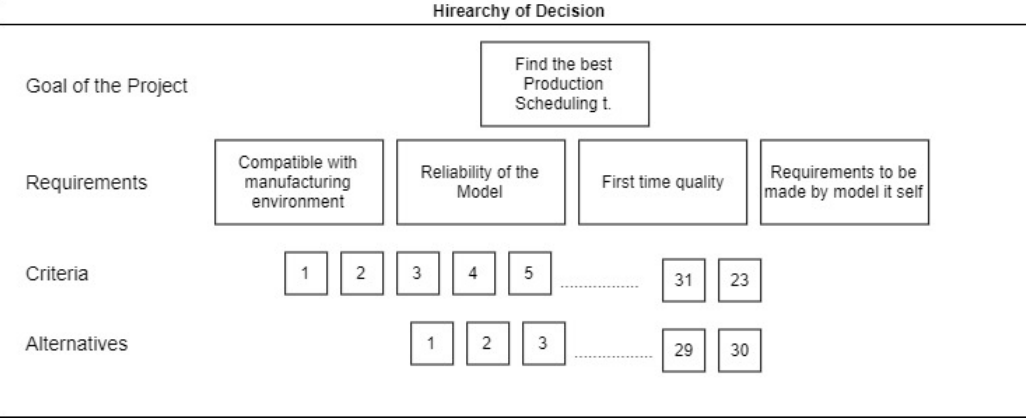
Figure 8. Decision hierarchy